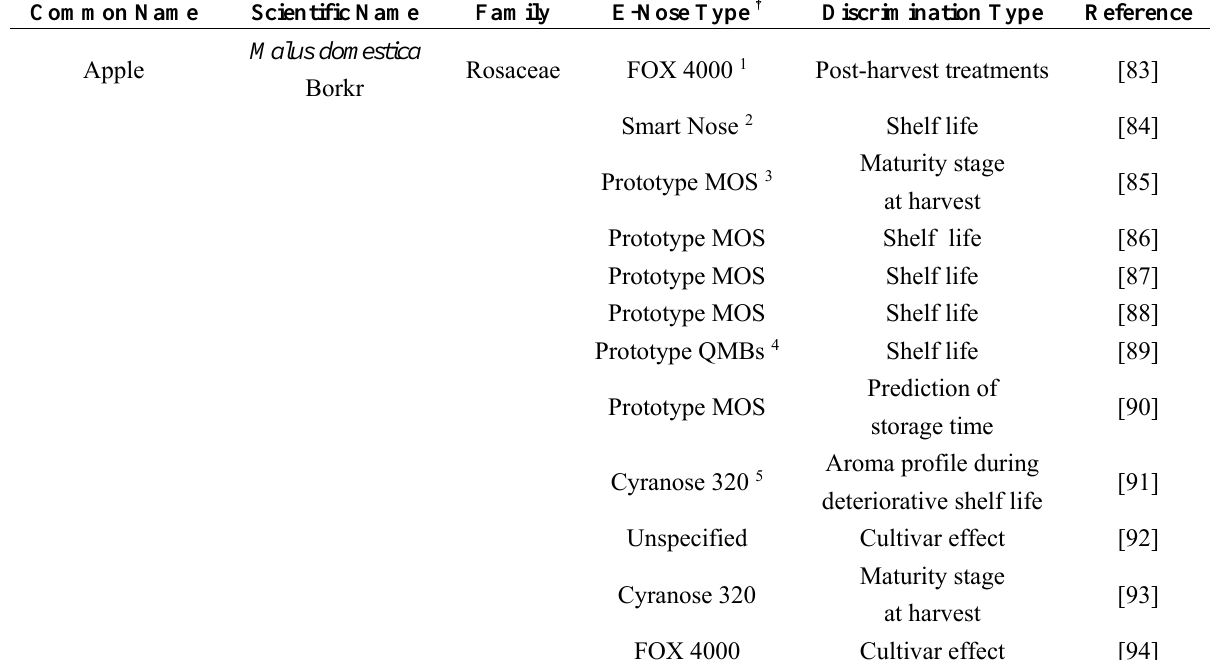
Table 3. Applications of electronic-nose devices for fruit aroma